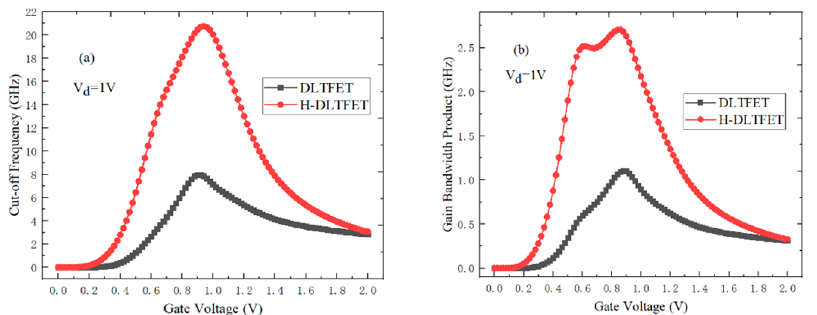
Figure 10. ( a ) Cutoff frequency and ( b ) the gain bandwidth product of the DLTFET and the H-DLTFET.